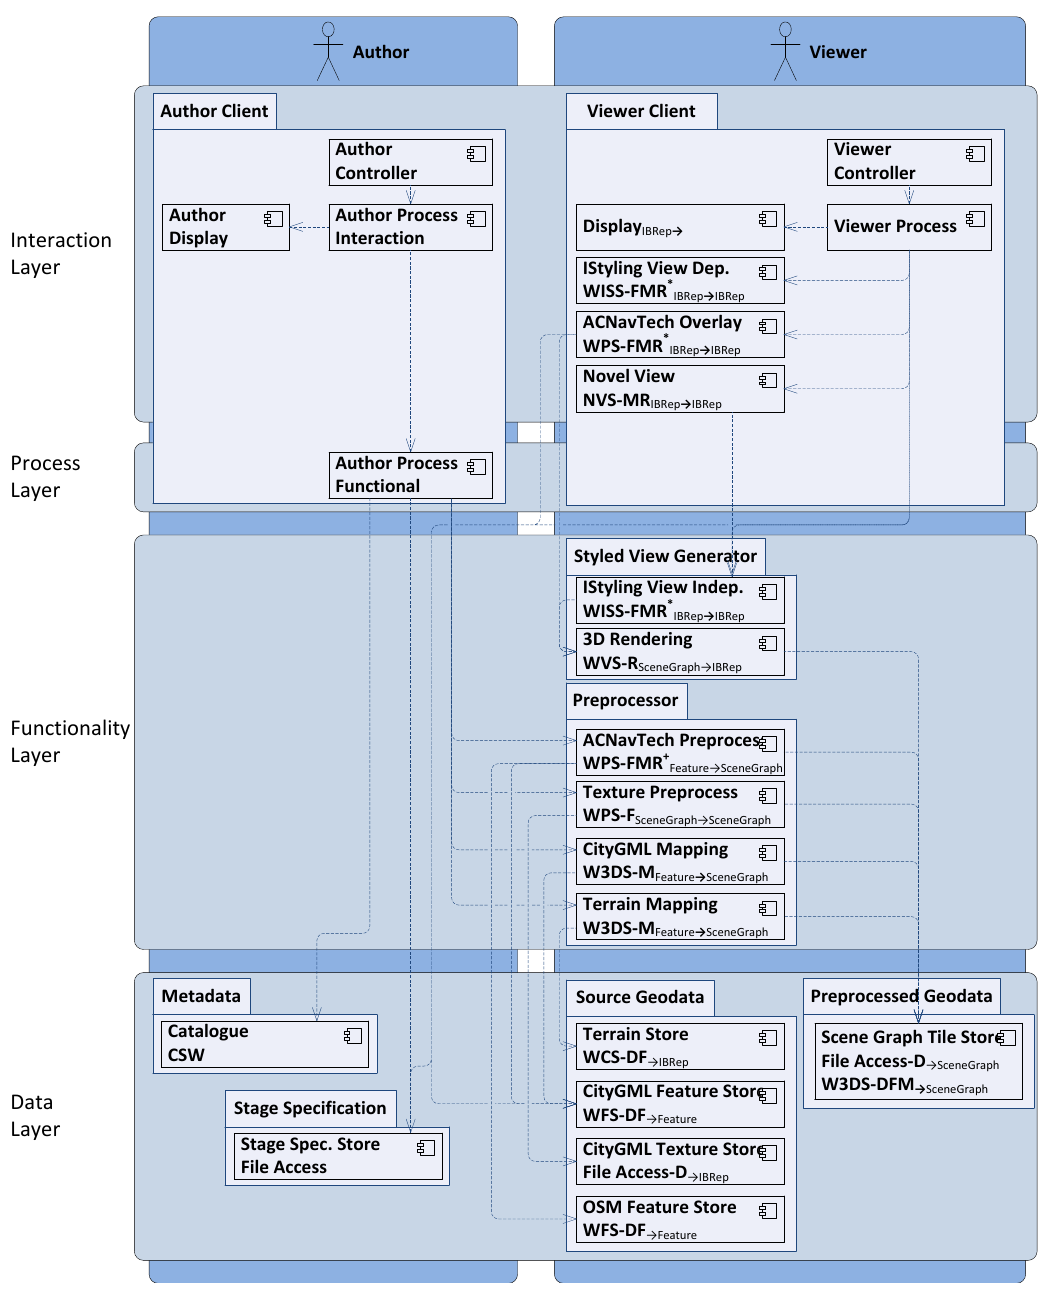
Figure 10. Overview of the logical software architecture of a 3DGeoVS based on SSI derived from the proposed